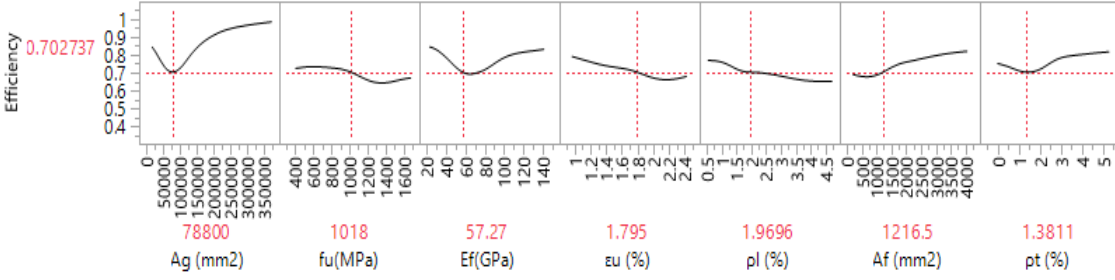
Figure 6. Prediction profiler of all parameters for GFRP-based RC columns (specimens) .